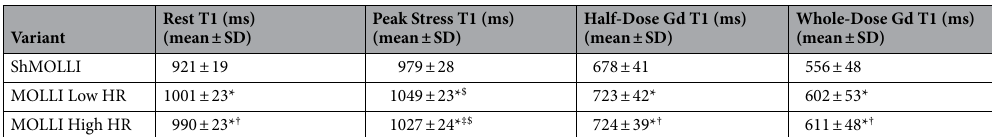
Table 1. Differences in T1 measurements between methods for rest, stress, and post-contrast T1. * = P < 0.001 compared with ShMOLLI. † = P > 0.05 compared with MOLLI Low HR. ‡ = P < 0.001 compared with MOLLI Low HR. $ Stress T1 data for MOLLI Low and High HR from extrapolated model-predicted dT1. Post-contrast T1 reflects the average T1 across each epoch, with statistical comparisons performed at N = 44 samples (based on the maximum number of MOLLI samples per epoch) to assure fair inter-method comparison.